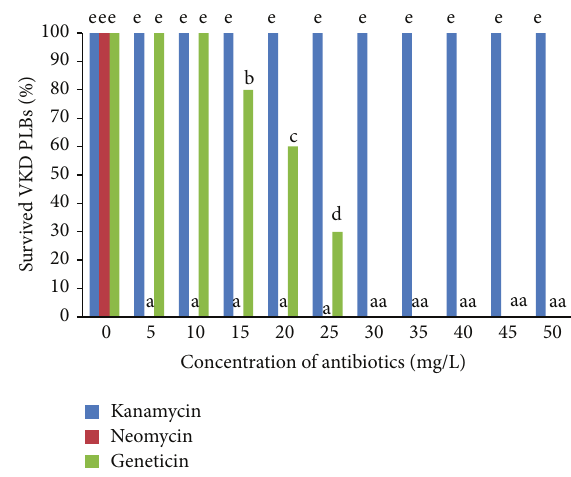
Figure 3: Percentage of survival of the VKD’s PLBs after four weeks in selection media containing various concentrations of different antibiotics. Data were analysed using one-way ANOVA and the differences contrasted using Tukey’s multiple comparison test. Different letters indicate values which are significantly different (𝑃 ≤ 0.05)